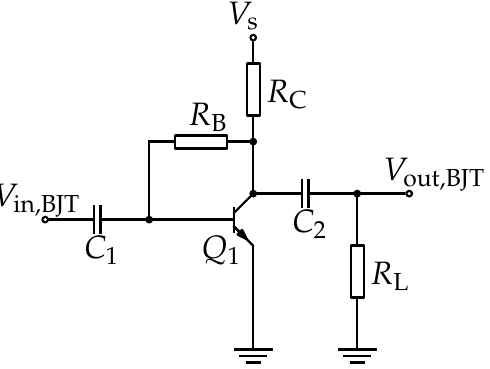
Figure 11. Schematic of the BJT amplifier with emitter architecture.